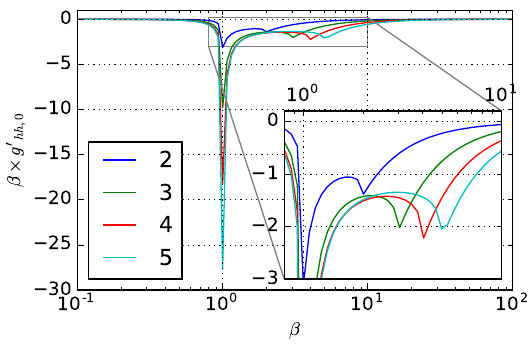
Figure 2. 0th-order weighting function magnitude with respect to optical constant for materials with k = 0. The legend in the figure shows the corresponding n value for each curve. Inset plot corresponds to the region in the gray